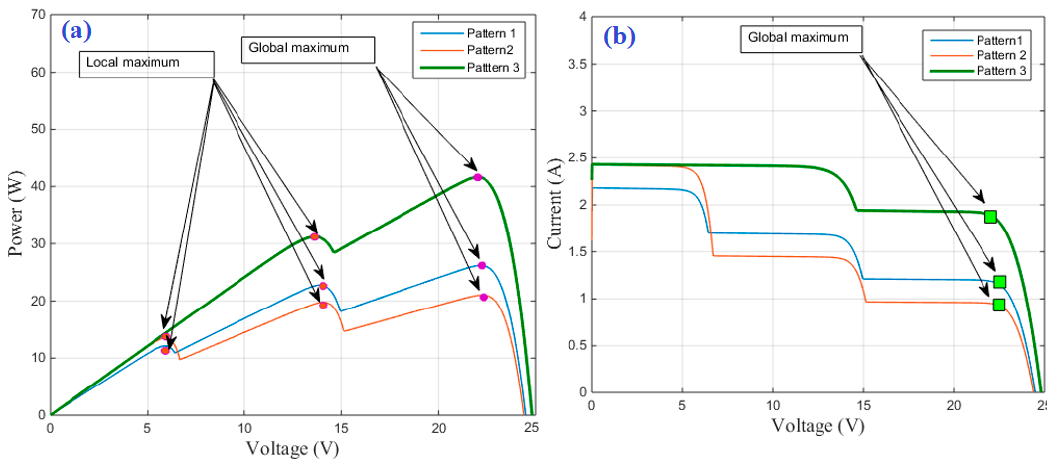
Figure 2. ( a ) Power versus voltage curves ( b ) current versus voltage curves of PVS under uniform irradiance and different partial shading patterns.